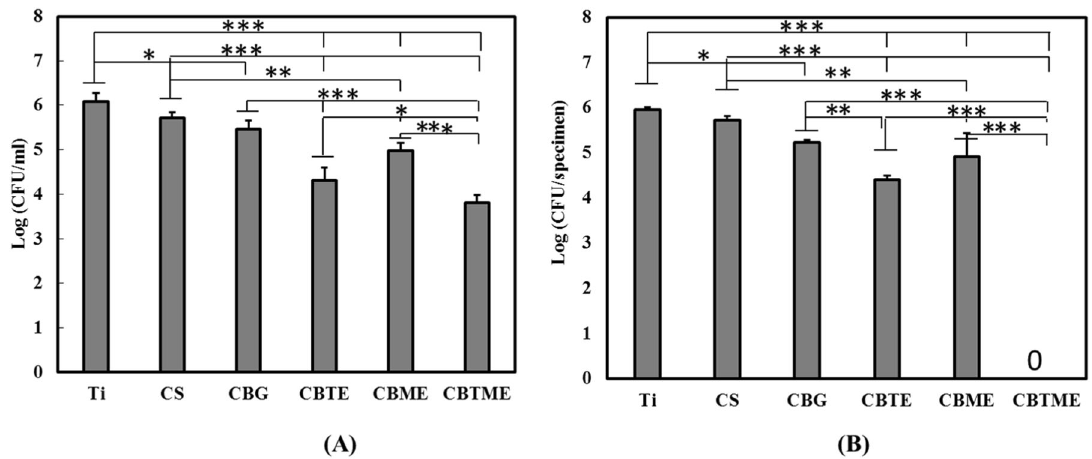
Fig. 7 A The numbers of planktonic bacteria. B The numbers of adhered bacteria on different surfaces (* P < 0.05, ** P < 0.01, *** P <